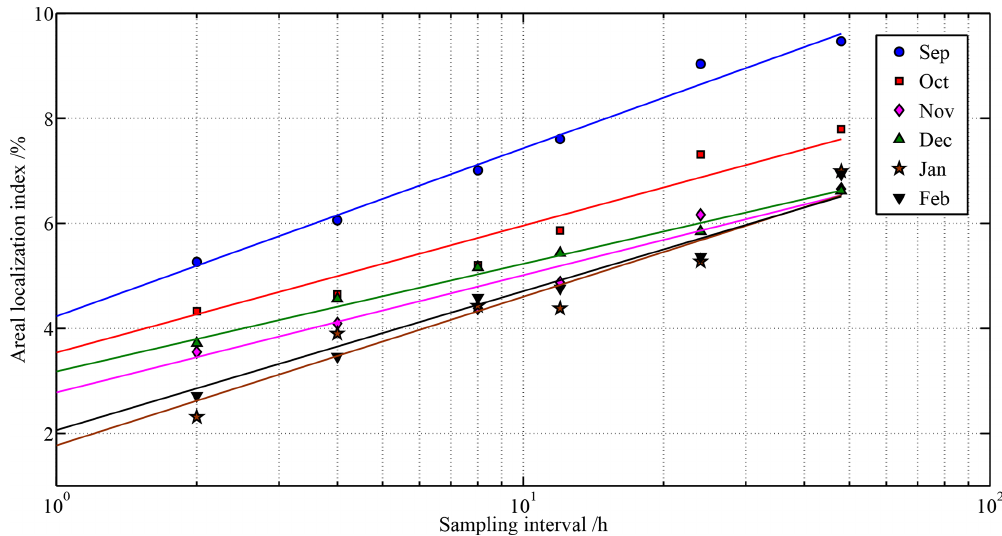
Figure 15. Changes in monthly (September 2018 to February 2019) areal localization index of ice deformation at a scale of 10–20km as a function of the position data resampling